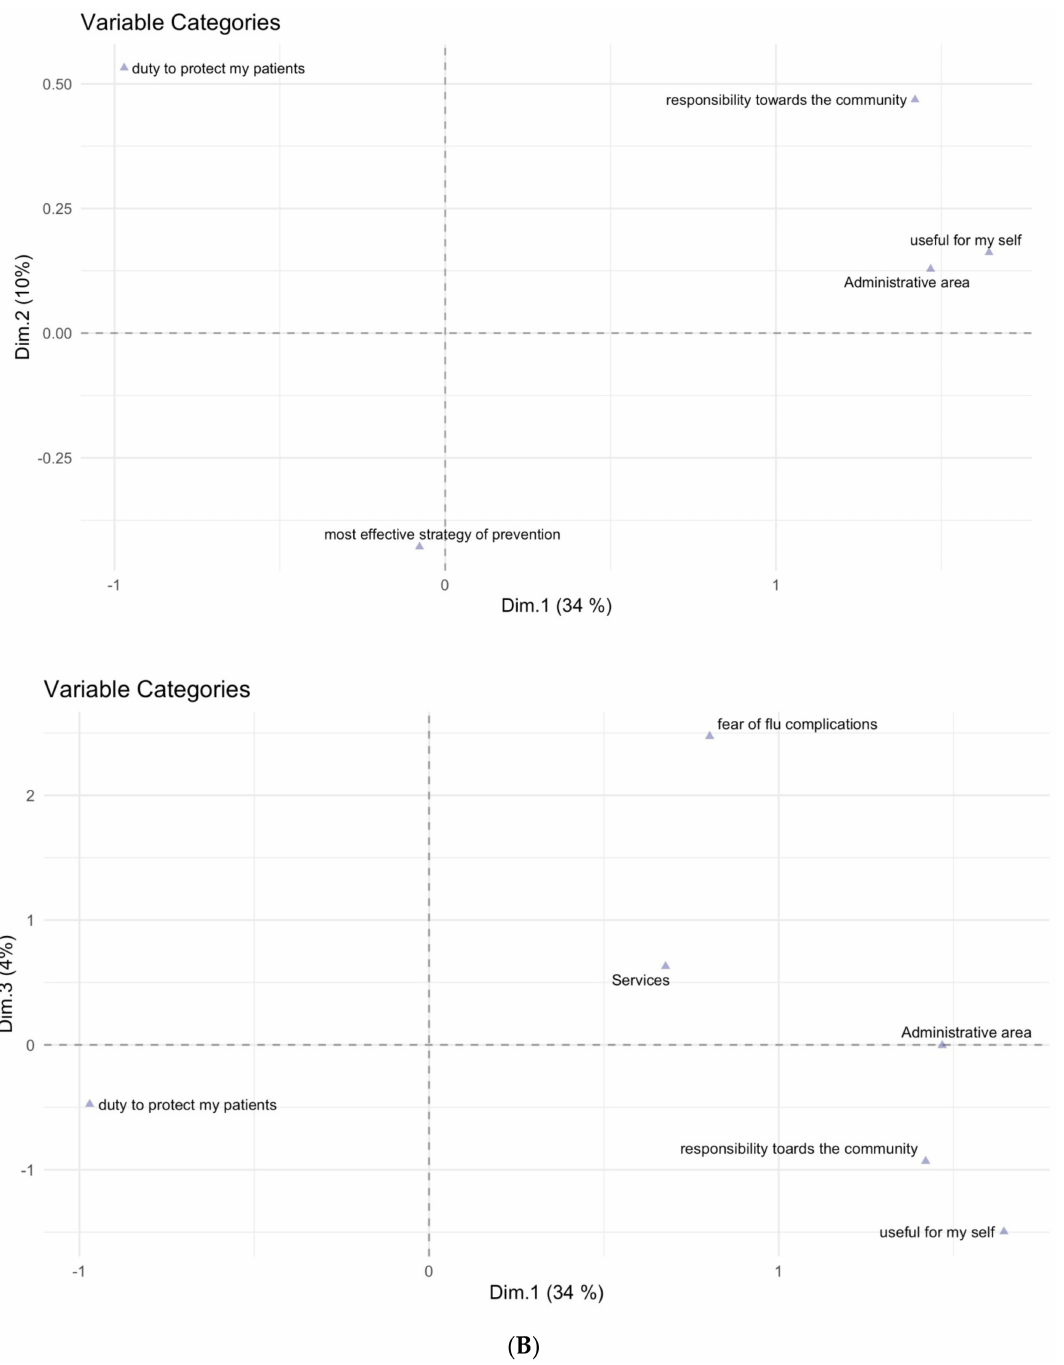
Figure 1. ( A ). HCWs’ qualifications and reasons for flu vaccination uptake resulted to be associated in the new planes defined by the first three dimensions (Dim 1, Dim 2, and Dim 3) computed by the MCA. The three dimensions can be considered as new variables that try to summarize the variability present in the dataset in a quantitative way. This way, particular response profiles characterized by different values of these new dimensions can be extracted from the individual responses that were given to the questionnaire questions. For better interpretability, labels of different reasons have been shortened as follows: reason 1, i.e., “Vaccination is the most effective strategy of